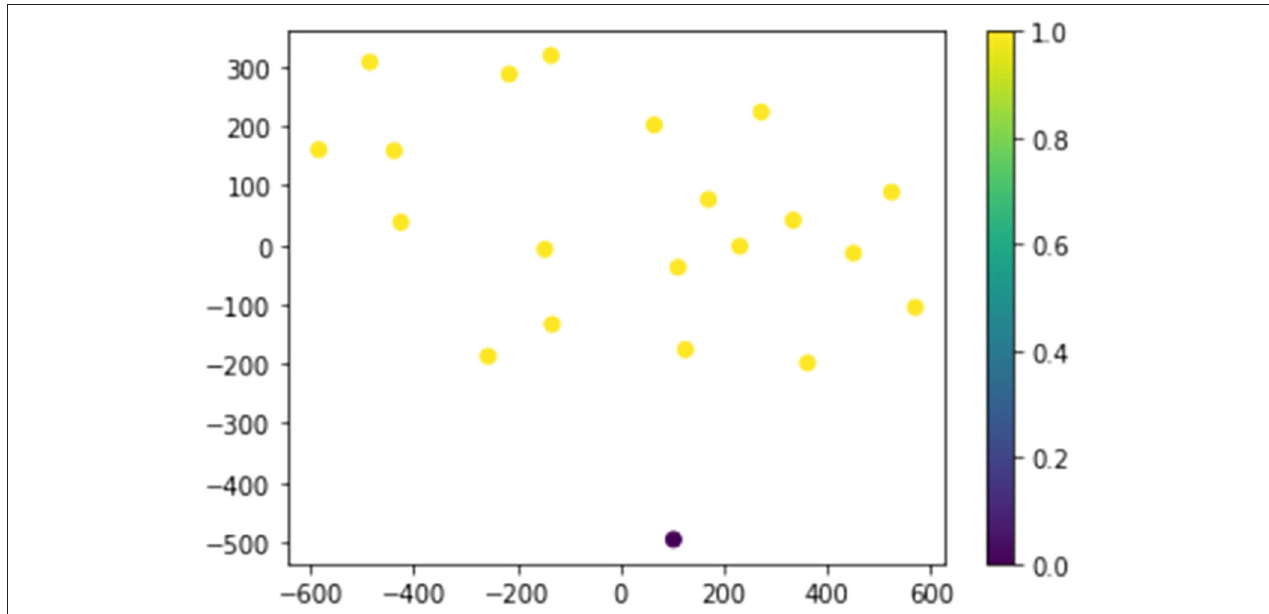
FIGURE 1 | The COVID-19 case patient and 20 healthy control subjects plotted in two dimensions following dimensionality reduction by stochastic neighbor embedding. The Purple dot represents the COVID-19 patient, while the yellow dots represent the healthy controls. The dimensionality reduction shows that based on 59 plasma analyte concentrations, the COVID-19 patients is distinct and easily separable. The axes are